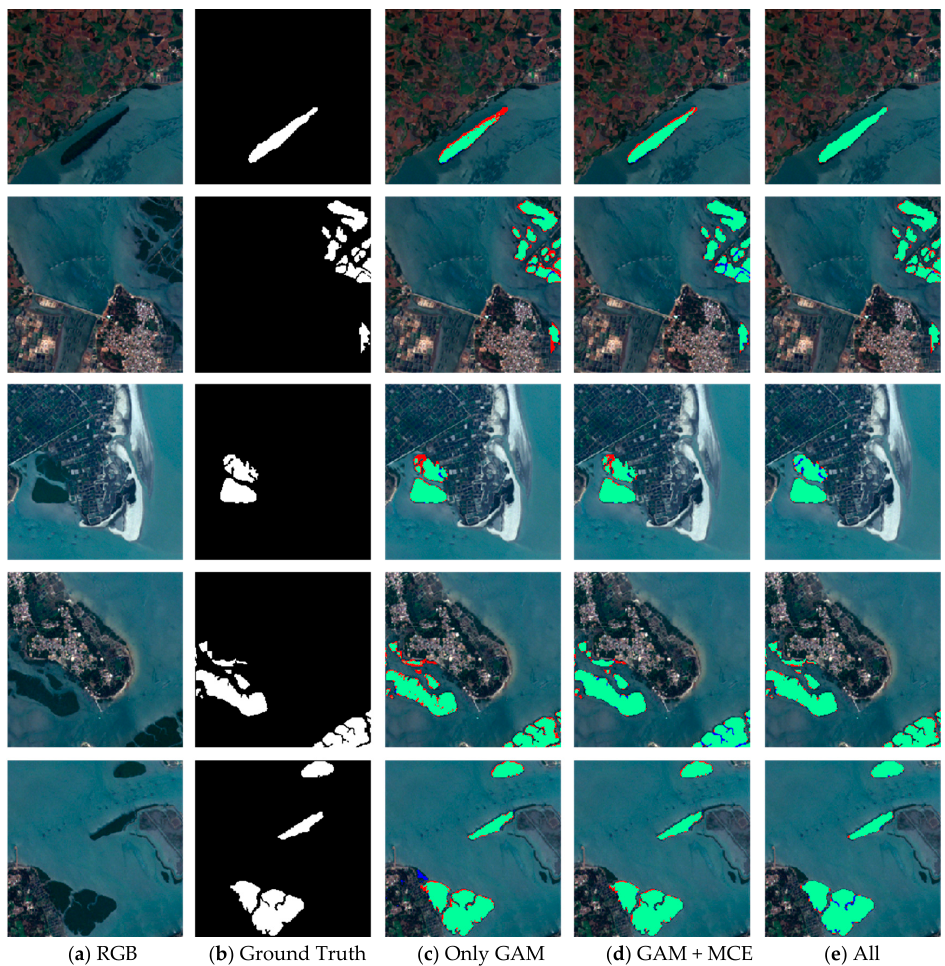
Figure 11. Results of mangrove extraction in a new mangroves region by different modules in ME-Net. The original images ( a ), the corresponding ground truth ( b ), and predictions ( c – e ) are presented. Green, red, blue, and black represent true positive (TP), false positive (FP), false negative (FN), and true negative (TN) respectively.